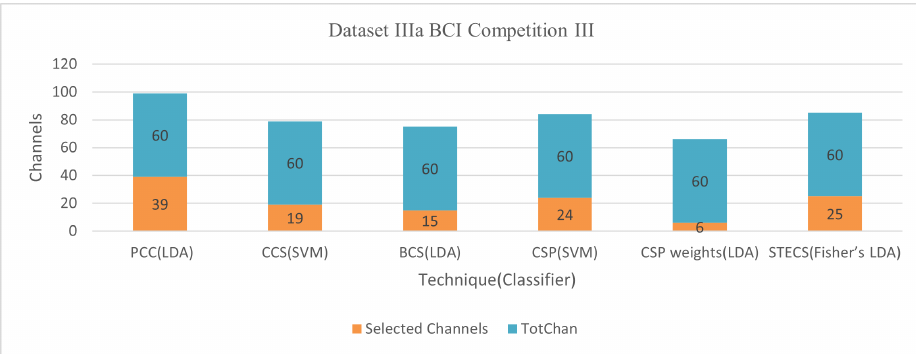
Figure 10. Selected channels by different techniques for Dataset IIIa BCI Competition